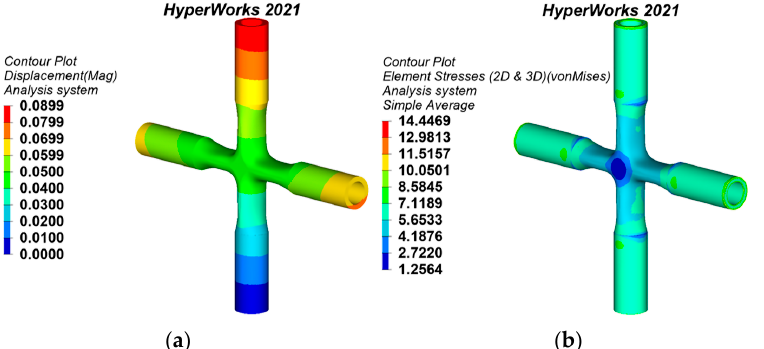
Figure 9. Static analysis results of generative joint 3: ( a ) displacement nephogram, ( b ) equivalent stress nephogram.